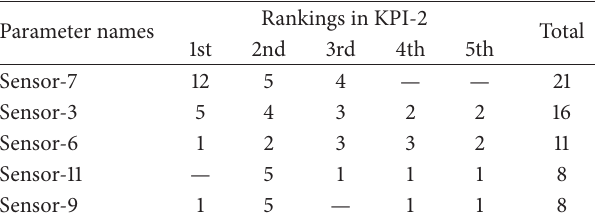
Table 10: Summary of 10 computational run times of heuristic approach for different number of